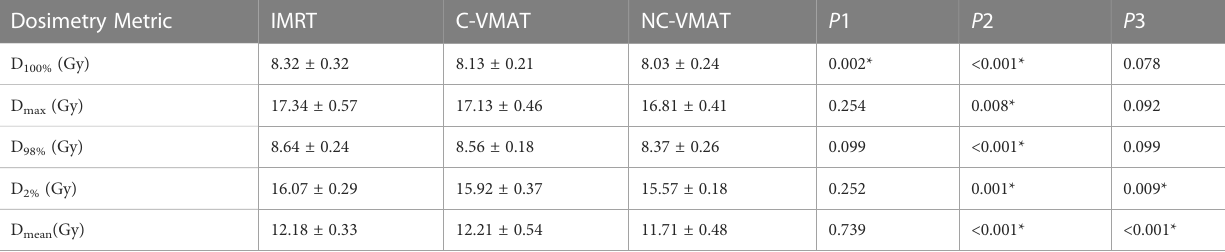
TABLE 6 The dosimetric values (mean ± SD) of hippocampus under three types of treatments (IMRT, C-VMAT and NC-VMAT) and comparison of the three treatments in terms of dosimetry metric and related p values. Dosimetry